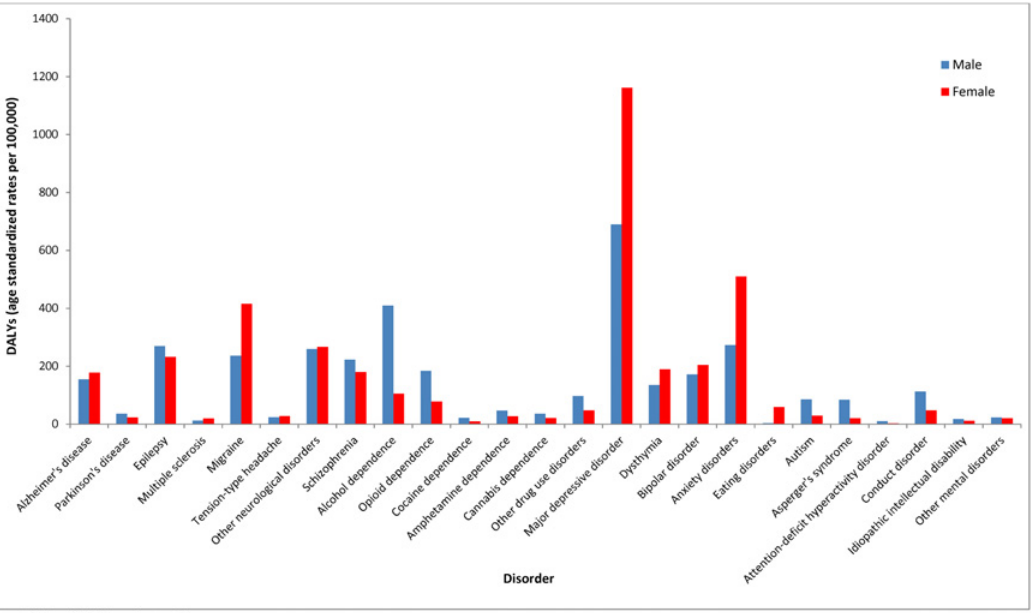
Fig 2. Age-Standardized DALY Rates Attributable to Individual Mental, Neurological, and Substance Use Disorders, by Gender, 2010.